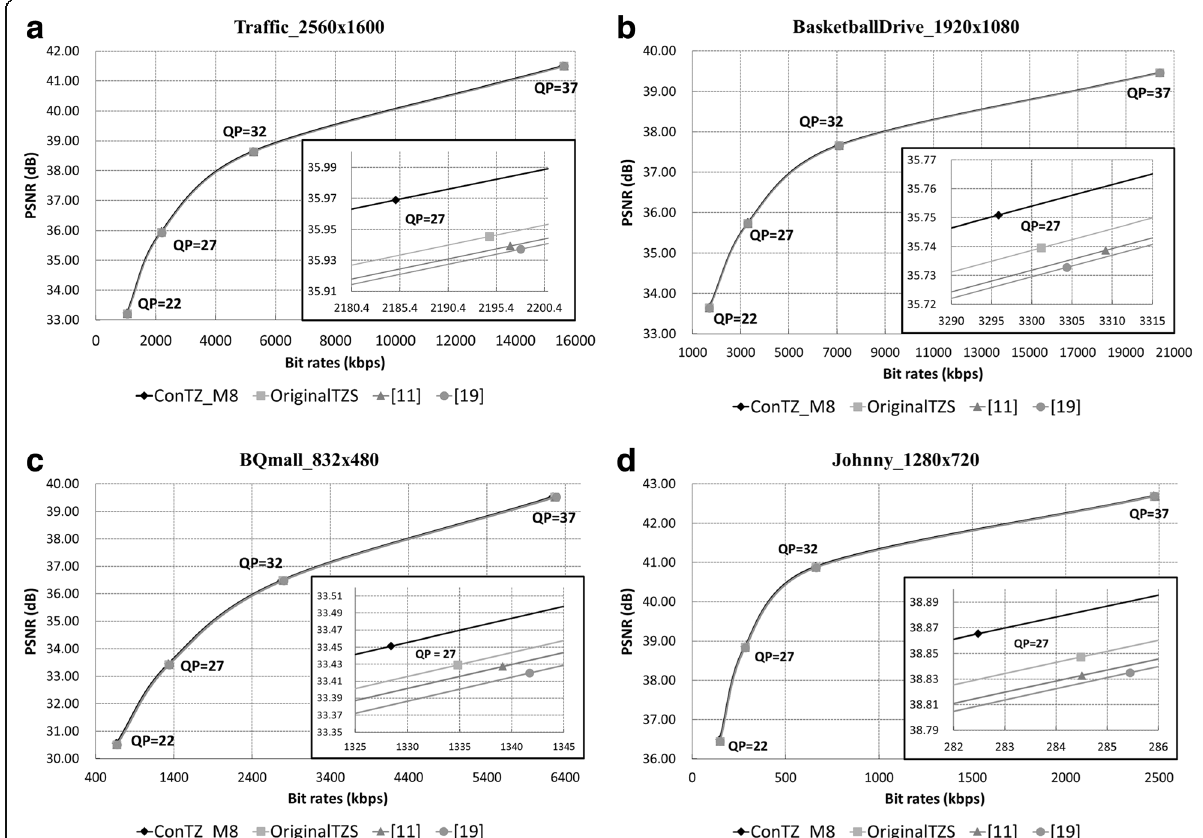
Fig. 13 RD performance of the proposed algorithm and others in various test sequences. a Traffic 2560 × 1600. b BasketballDrive 1920 × 1080. c BQMall 832 × 480. d Johnny 1280 ×